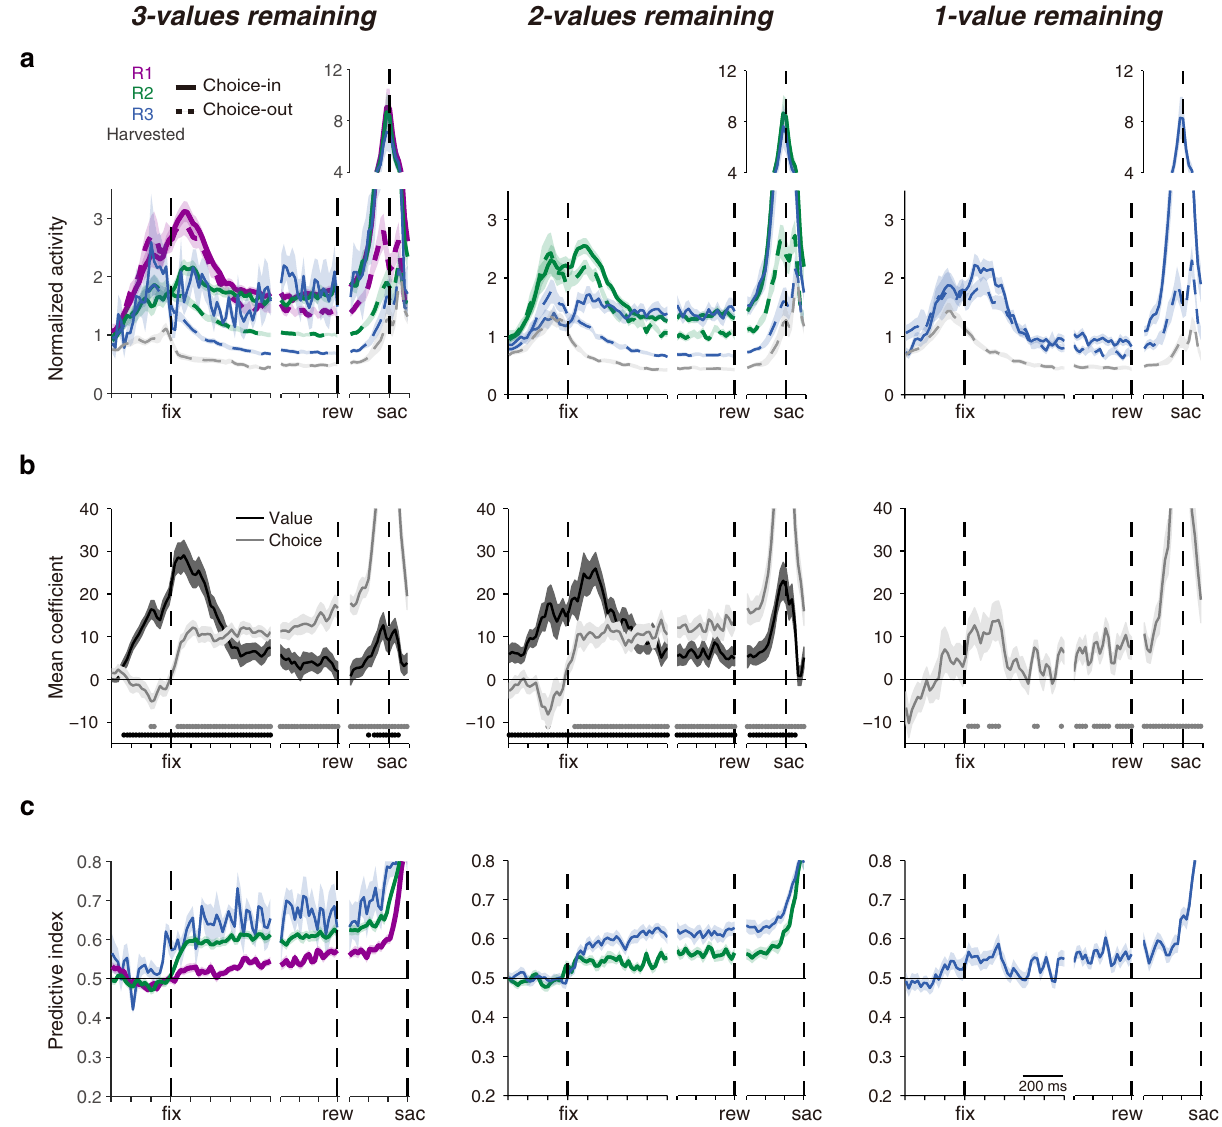
Fig. 4 The evolution of value and choice signals in SC activity across 3 menus. a Normalized neuronal activity was segregated based on the rank value of the target in the response fi eld and whether a saccade was ultimately directed to the response fi eld target (solid lines) or a target outside the response fi eld (dashed lines). Otherwise, the same format as Fig. 3. b The evolution of the population regression coef fi cients for value ranking (black) and choice direction (gray). There is no value plot in the rightmost 1-value remaining panel because all remaining targets had the same, lowest value. The time points with statistically signi fi cant regression coef fi cients by value ranking (black dots) and choice direction (gray dots) was shown at the bottom of the panel ( t test, P <0.05, with false-discovery rate correction). c The evolution of neuronal choice selectivity toward targets of different value rankings. The receiver-operating characteristic analyses were done between activities associated with choices toward the response fi eld target versus targets outside the response fi eld that shared the same value. All shaded regions represent